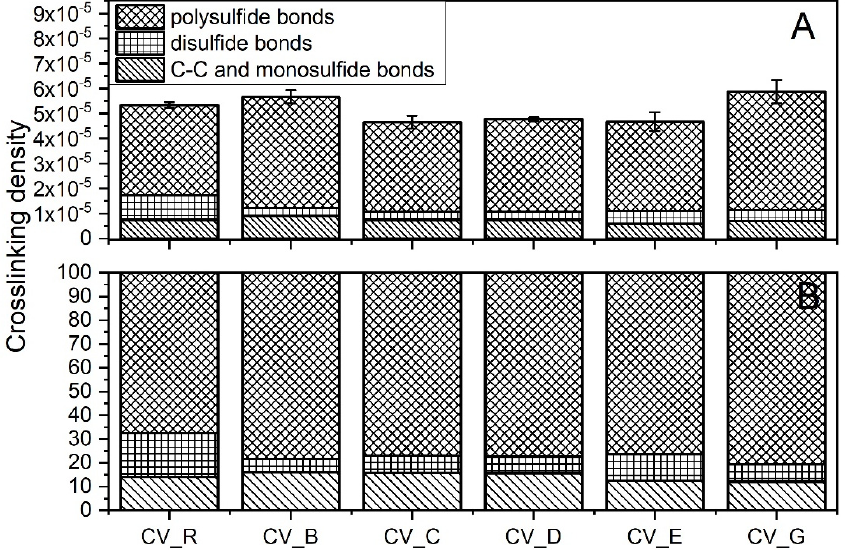
Figure 6. Crosslink structure of the rubber compounds prepared in the CV system: ( A ) content of crosslinks (mole/cm 3 ); ( B ) division of crosslinks [%]. CV_...—rubber compounds containing n-ZnO